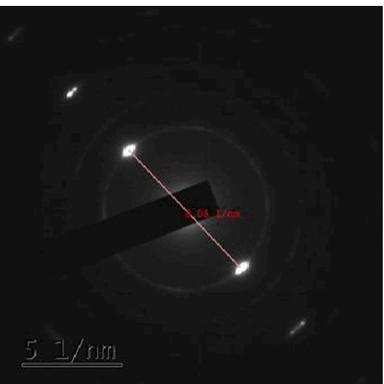
SAED pattern of RbCl doped MgO nanoparticle.